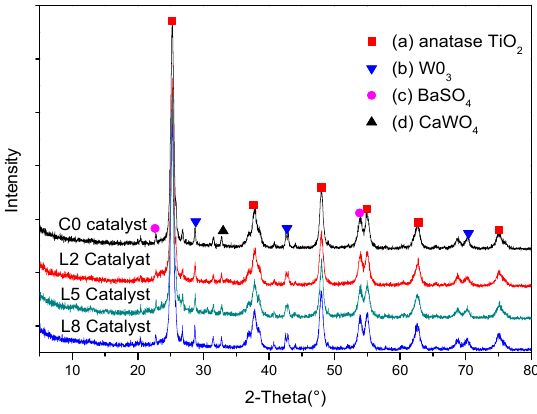
Figure 8. X-ray diffraction (XRD) spectra of the catalysts: ( a ) anatase TiO 2 ; ( b ) WO 3 ; ( c ) BaSO 4 ; and ( d ) CaWO 4 .